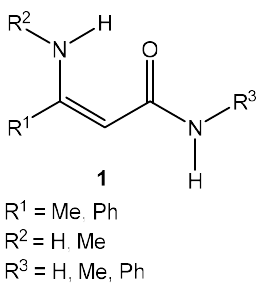
Figure 1. General structure of simple enaminoamides.